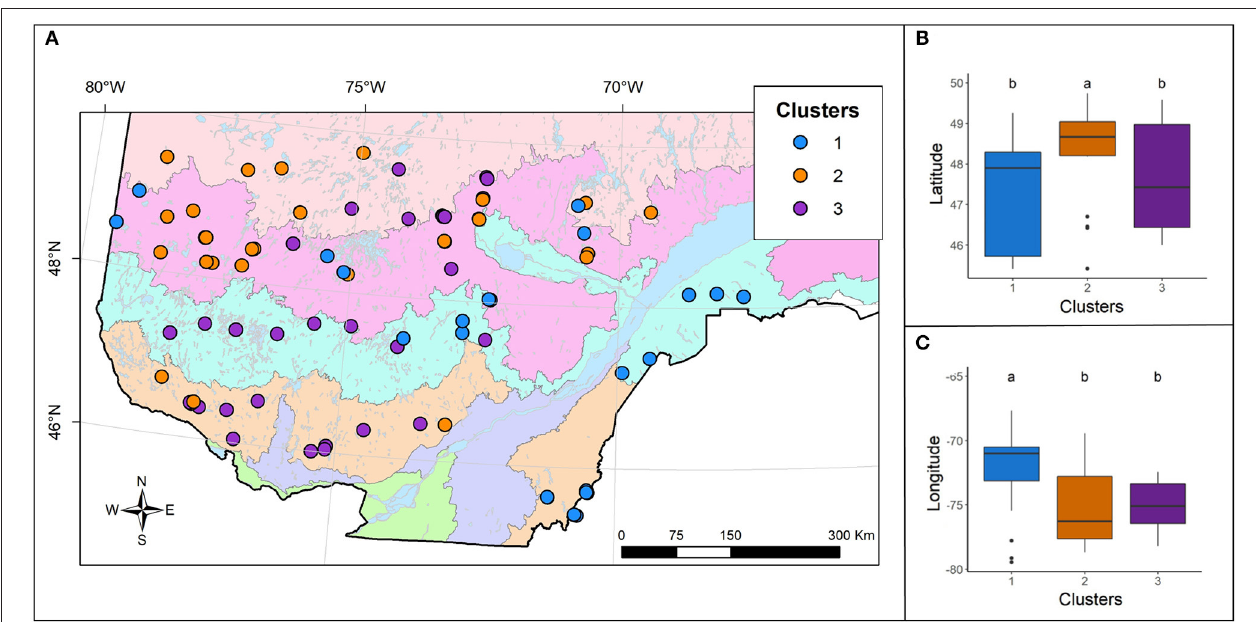
FIGURE 3 | (A) Spatial distribution of the three observed clusters. For the background map legend see Figure 1 . Boxplots representing (B) the mean latitude and (C) longitude for each cluster, presented with the post-hoc test results (a > b).